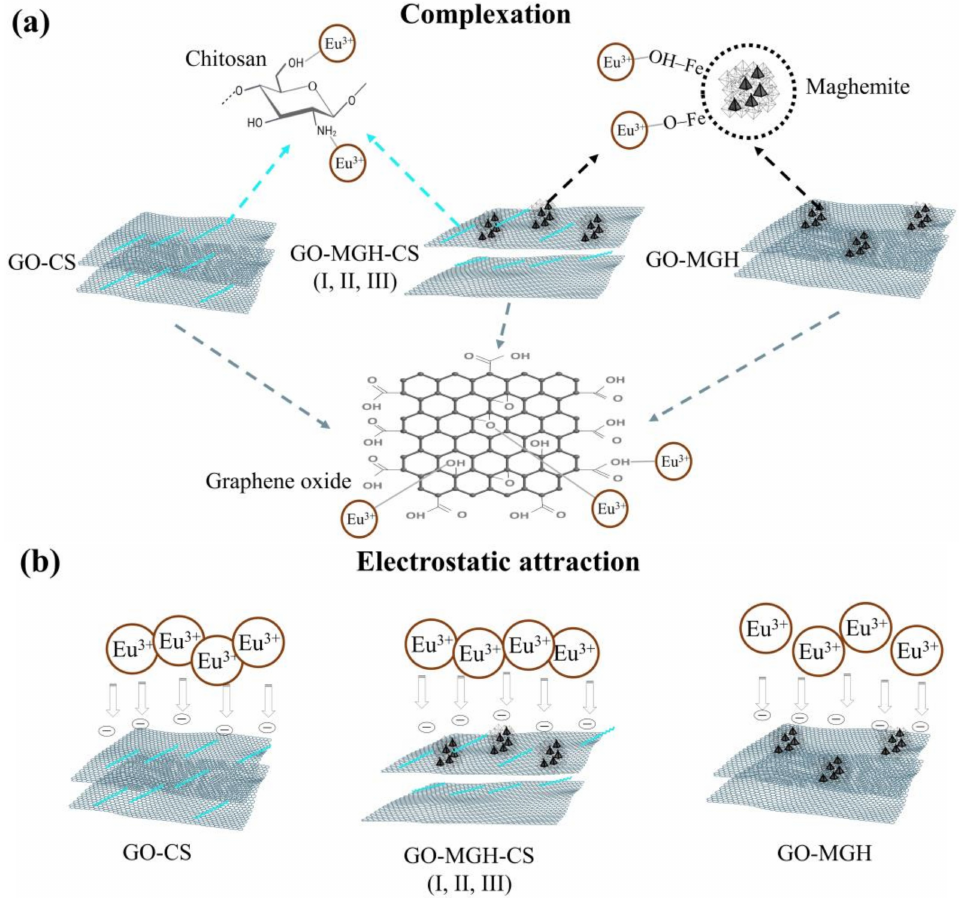
Figure 8. Proposed mechanism of adsorption of Eu(III) on composites by complexation ( a ) and electrostatic attraction ( b